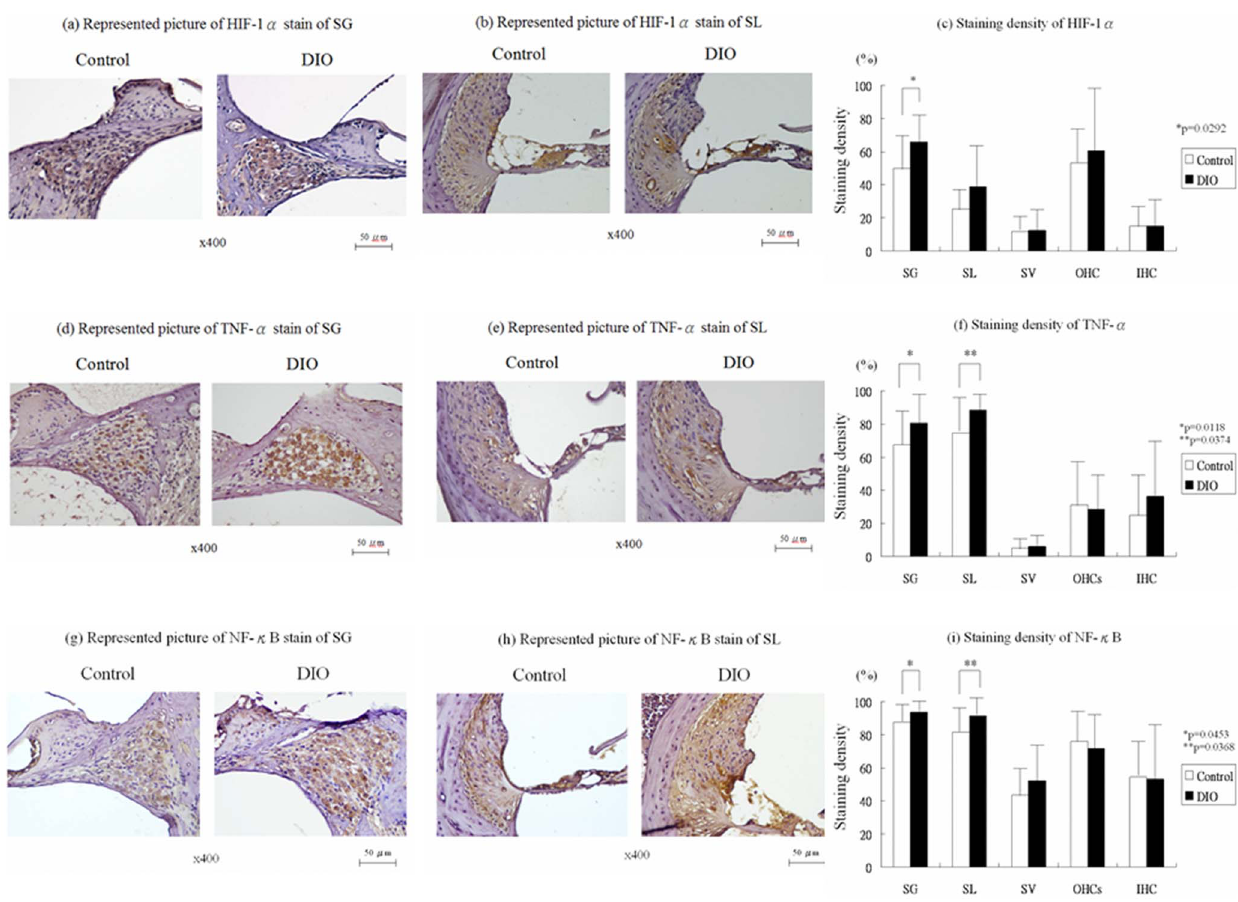
Figure 1. Immunohistochemical studies of cochlea. Representative radial section of hypoxia-induced factor (HIF) 1- a staining in the cochlear basal turn (a,b). The intensity of HIF-1 a stain was significantly greater in the DIO group than in the control group in the SG and SL (c). Representative radial section of TNF- a stain in the cochlear basal turn (d,e). The intensity of tumor necrosis factor (TNF)- a stain was significantly tenser in the DIO group than in the control group in SG and SL (f). Representative radial section of NF- k B stain in the cochlear basal turn (g,h). The intensity of nuclear factor kappaB (NF- k B) stain was significantly greater in the DIO group than in the control group in SG and SL (i).